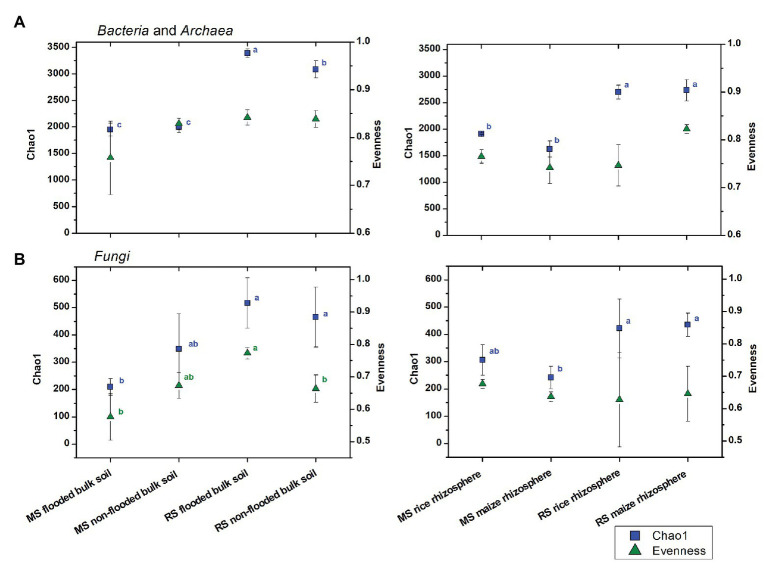
Changes in (A) bacterial and archaeal and (B) fungal alpha diversity measures in soils with different cropping history (maize soil, MS or rice soil, RS), management and cultivated crop plants. Mean values and standard deviations (SDs) of the diversity measures for bulk soil (left) and rhizosphere samples (right) are given. Significant differences between samples were assessed by ANOVA with Turkey HSD post hoc tests (p < 0.05) and are indicated by superscript letters in blue (Chao1) and green (evenness) when detected.